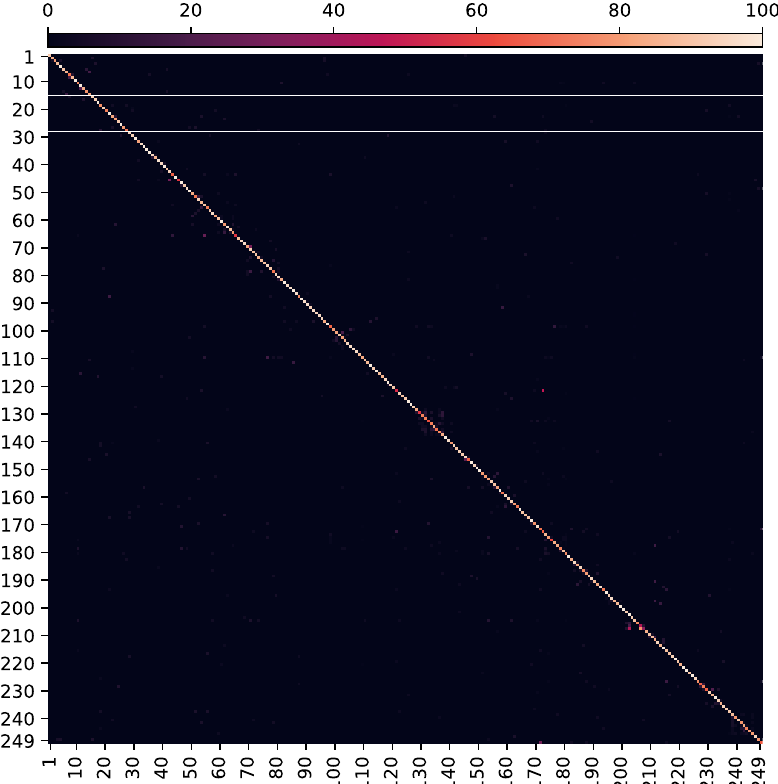
Figure 6. Illustration of the confusion matrix/heat-map of StaDNet evaluated on test set of the Chalearn 2016 isolated gestures recognition dataset. It is evident that most samples in the test set are recognized with high accuracy for all 249 gestures (diagonal entries, 86.75%